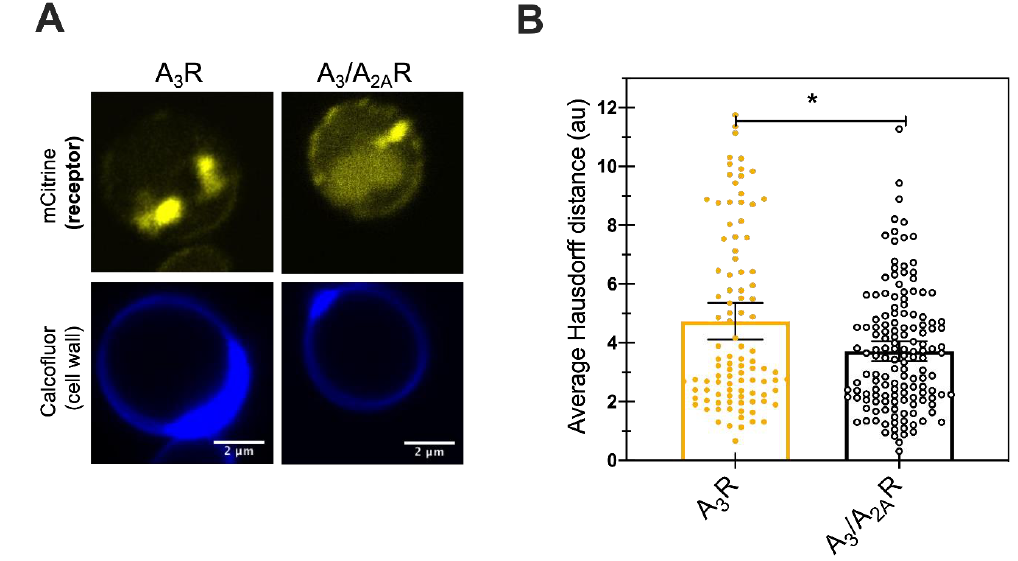
Figure 5. Small improvement in trafficking of chimera to the plasma membrane ( A ) Representative live-cell confocal microscopy images showing receptor localization of the mCitrine tagged receptors expressed in BY4741. Calcofluor stain was used to label the cell wall. Scale bar indicates 2 µm. ( B ) Quantification of the average Hausdorff distance for at least a hundred individual cells (points) per receptor. Bars show the mean, with error bars representing the 95% confidence interval. Student’s t -test was performed to determine significant difference between the two values. * represents p -value < 0.05.